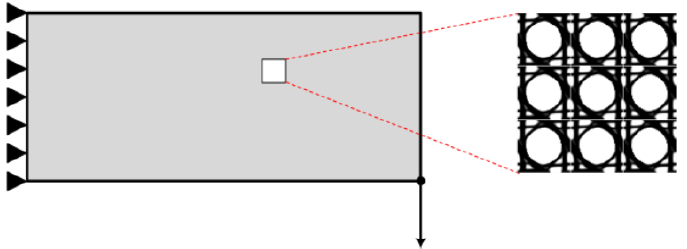
Figure 5. Optimized periodic unit cell for the cantilever beam 1 test example macro